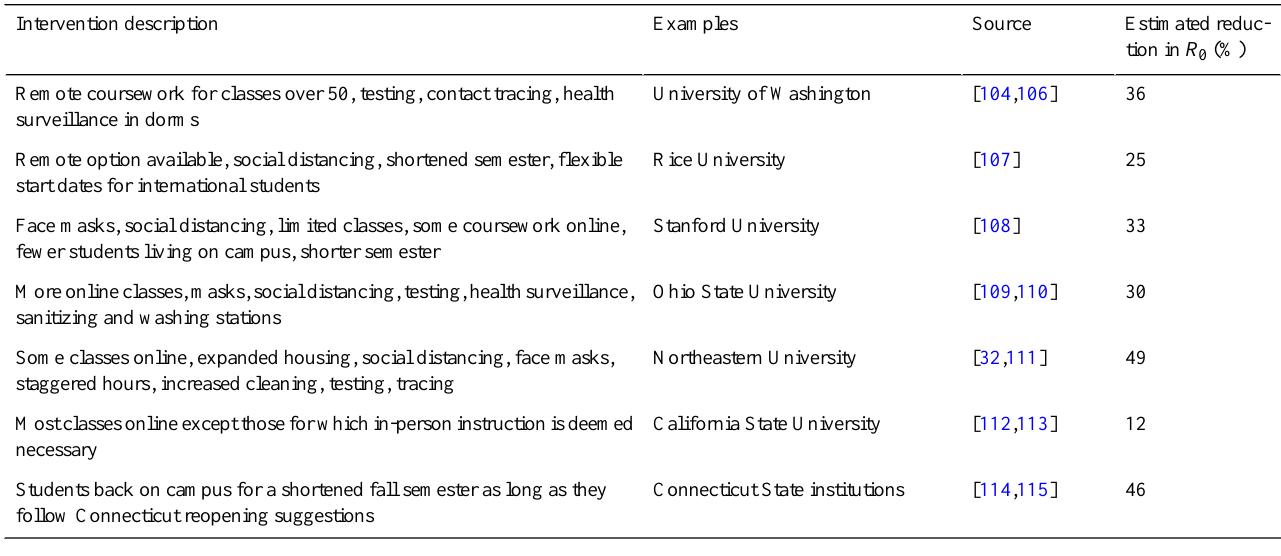
Table 2. Representative examples of US university and college COVID-19 fall 2020 semester campus reopening plans. (%)SourceExamplesIntervention